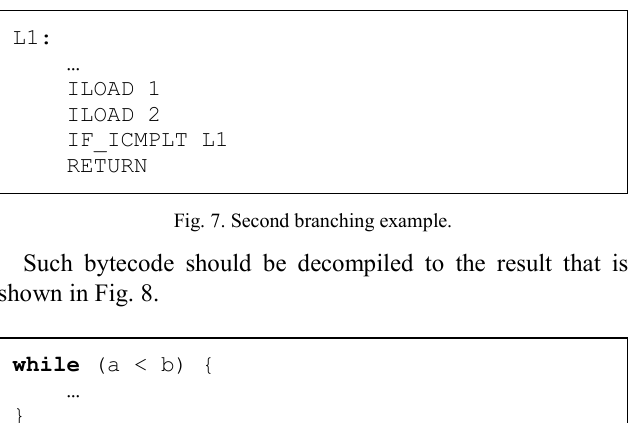
Fig. 10. Random number generation method – Java